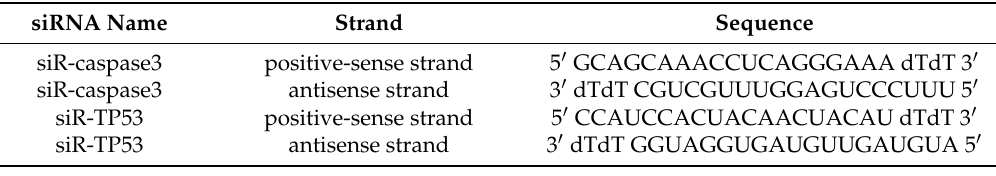
Table 2. The siRNA sequences were artificially synthetized accordingly.